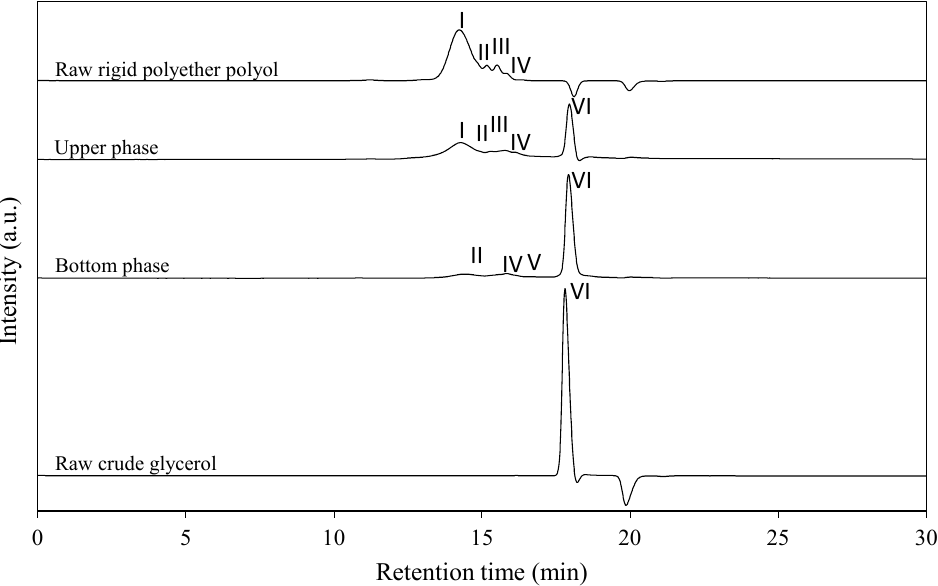
Figure 4. GPC chromatograms of the UP and BP at 360 min and of raw rigid polyether polyol and crude glycerol. Peaks I, II, III and IV = rigid polyether polyol; Peak V = reaction by-products; Peak VI = Crude glycerol.